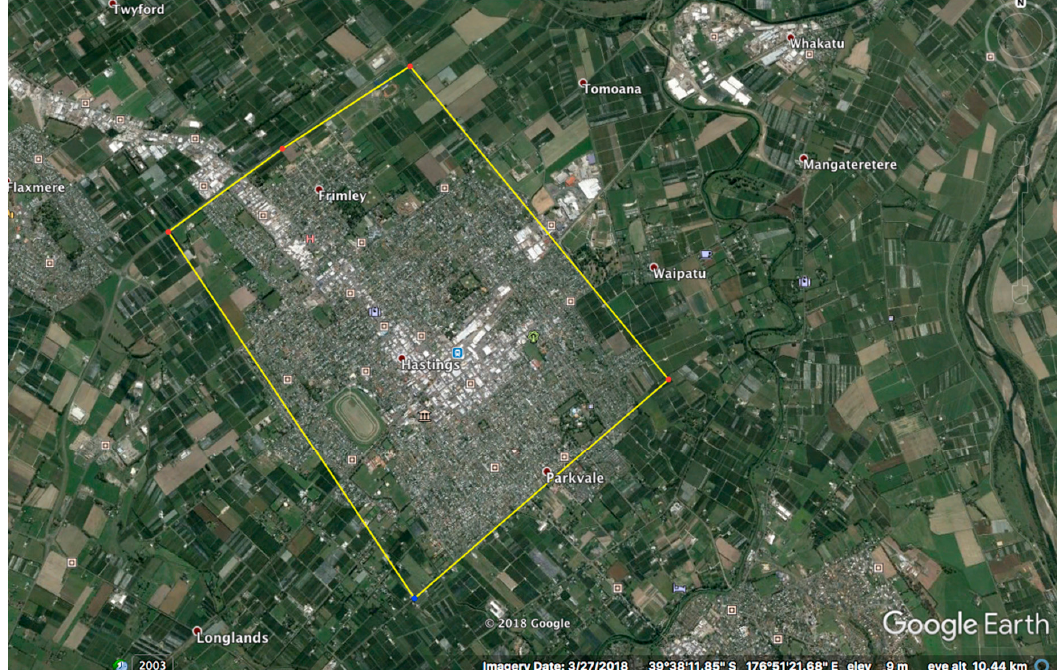
Figure 1. The location chosen for study of community attitudes to codling moth eradication and the Sterile Insect Technique using unmanned aerial vehicles was the indicated sample area of Hastings within Hawke’s Bay in New Zealand (peri-urban Hastings, 27,000 dwellings). Image courtesy Google Earth, 6/6/2019.